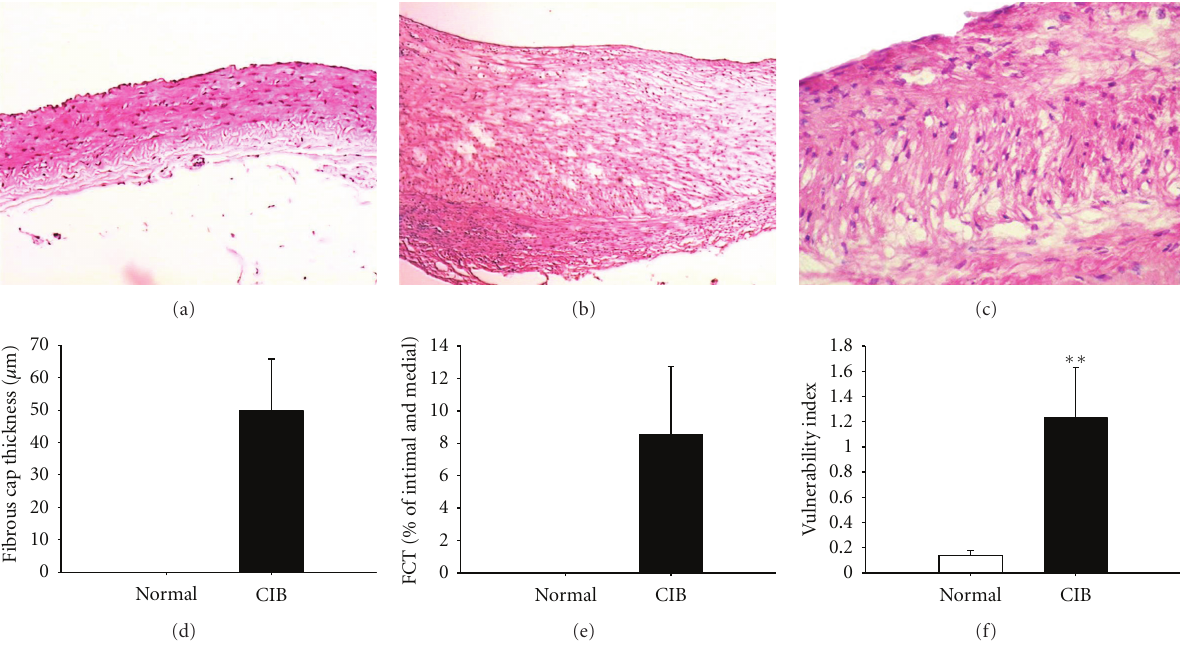
Figure 3: Histological examples of lipid core and the fibrous cap associated with rabbit atherosclerotic plaques. (a) A cross section of a normal rabbit aorta. (b) A cross section of a CIB rabbit atherosclerotic plaques. (c) Higher magnification of the atherosclerotic plaques site shows a thin fibrous cap. The fibrous cap thickness, (d) ratio of fibrous cap to intima media thickness (e), and vulnerability index (f) were calculated. Data are expressed as mean ± SD, ∗∗ P < 0 . 01 compared with